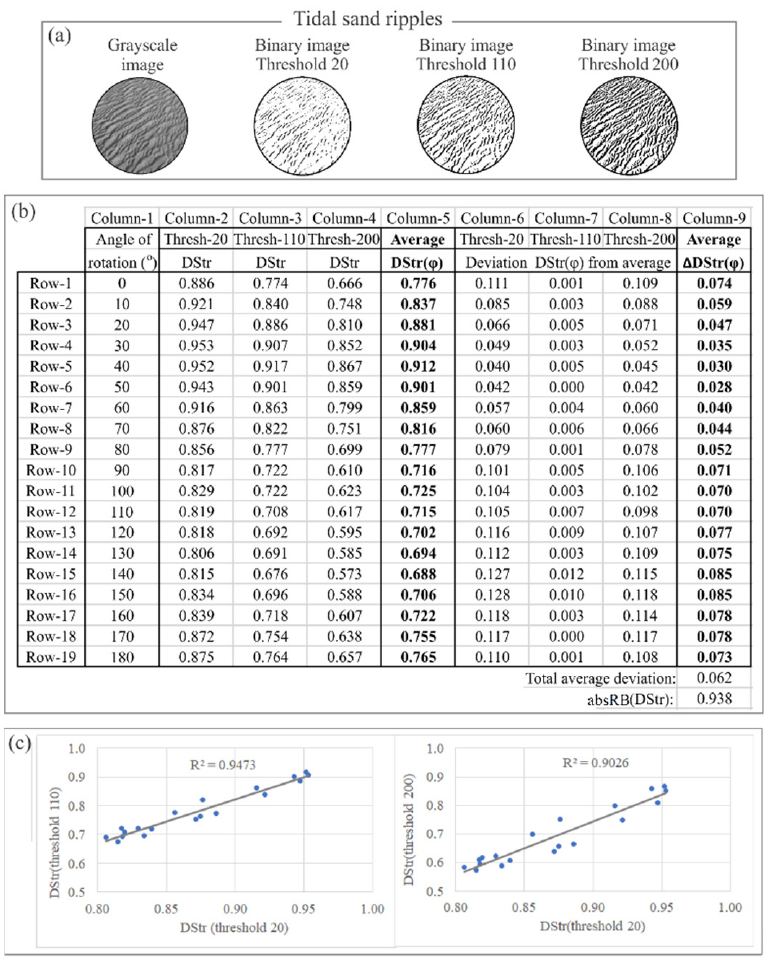
Figure 3. Absolute and relative robustness of DStr of a grayscale image against its binarization. ( a ) Grayscale image of tidal sand ripples and its binarization. ( b ) Absolute robustness of DStr with respect to binarization thresholds 20, 110, and 200. ( c ) Relative robustness of DStr as interclass correlation coefficient.